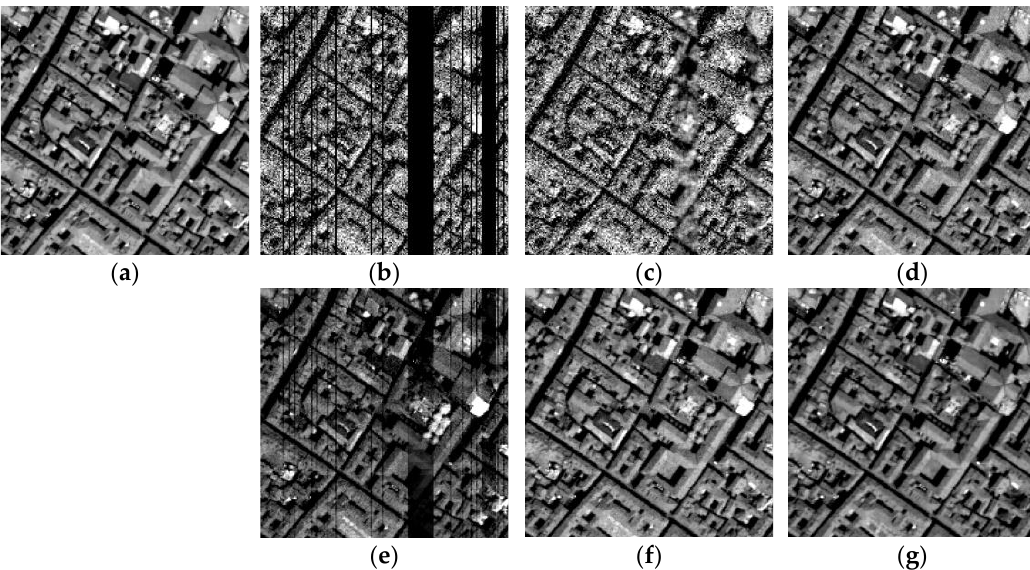
Figure 2. Inpainting results of band 60 of Pavia Centre dataset with Gaussian i.i.d. noise. ( a ) Clean image; ( b ) noisy image; ( c ) PDE; ( d ) UBD; ( e ) LLRSSTV; ( f ) BPFA; and ( g ) INORSDL.